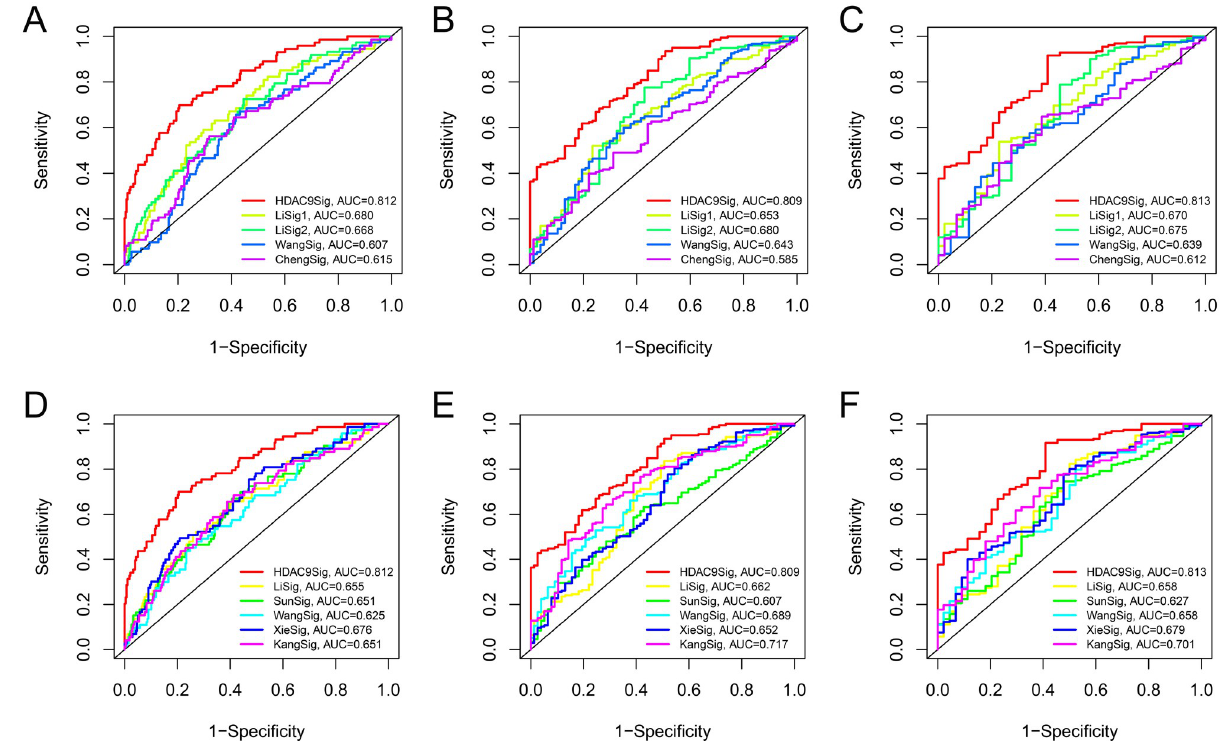
Fig 6. Comparison between signatures. By comparing with other signatures constructed through only prognostic-related genes (A-C) and other risk factors (D-F), our risk signature was found to be superior in performance.